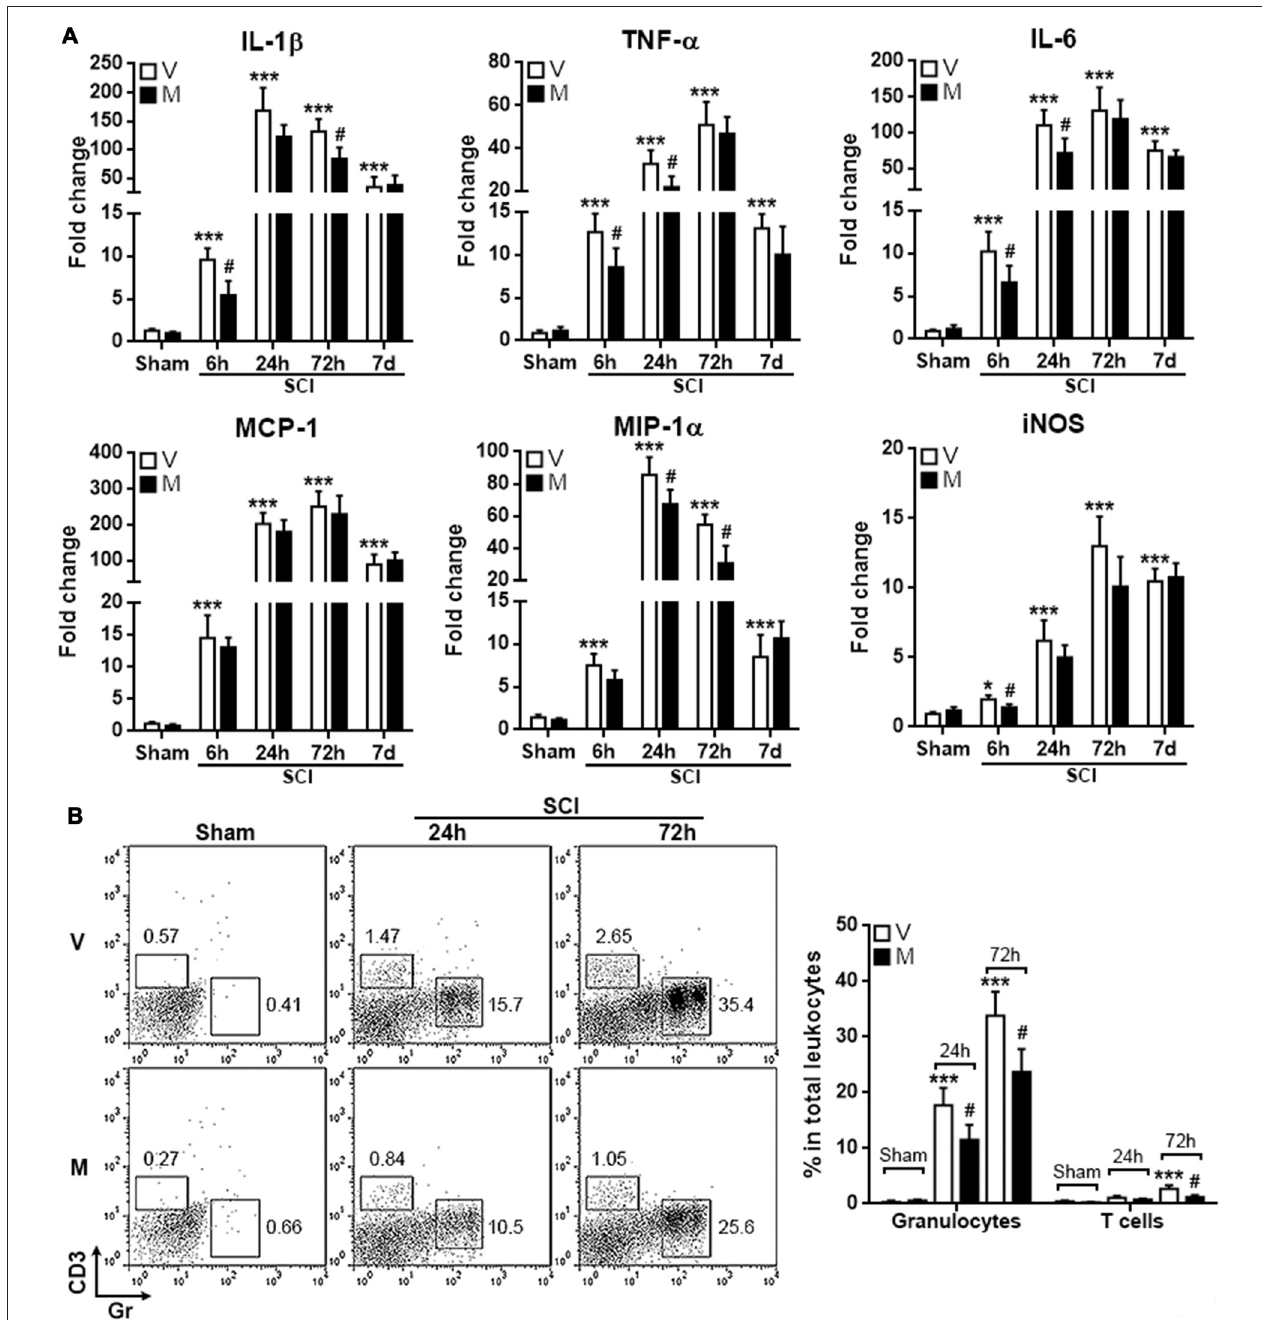
FIGURE 6 | Methylene blue mitigates the acute post-SCI neuroinflammation. (A) mRNA levels of indicated molecules at different time points post SCI. N = 6 per group. (B) Infiltration of CD3 + T cells and Gr + granulocytes into injured spinal cords. Left: representative flow cytometry dot plots. Right: statistics. N = 5 per group. V: vehicle; M: methylene blue treatment. ∗ p < 0.05; ∗∗∗ p < 0.001 in comparison with sham-vehicle group. # p < 0.05 in comparison with the corresponding vehicle group of each time point.